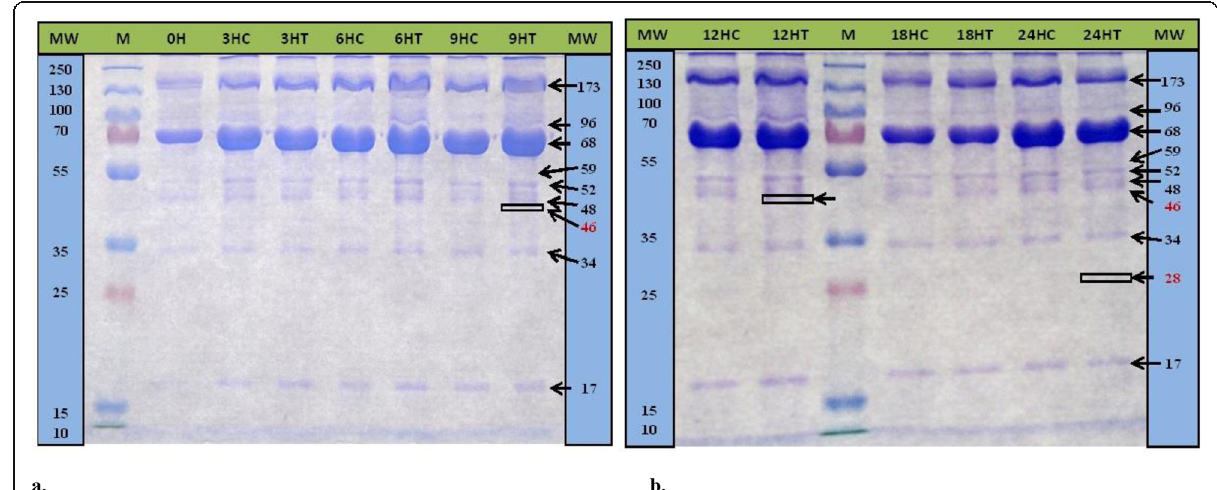
Fig. 2 A comparative electrophoretic profile of plasma fractions of a control (0, 3HC, 6HC, 9HC) and Steinernema abbasi - Xenorhabdus indica